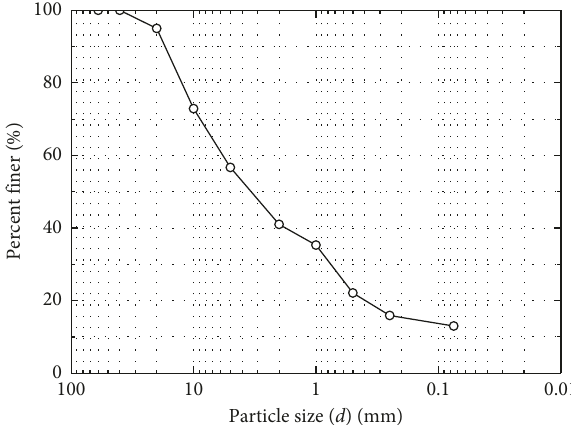
σ z / c z ; (b) B σ x / σ z . (cid:31) (cid:31)